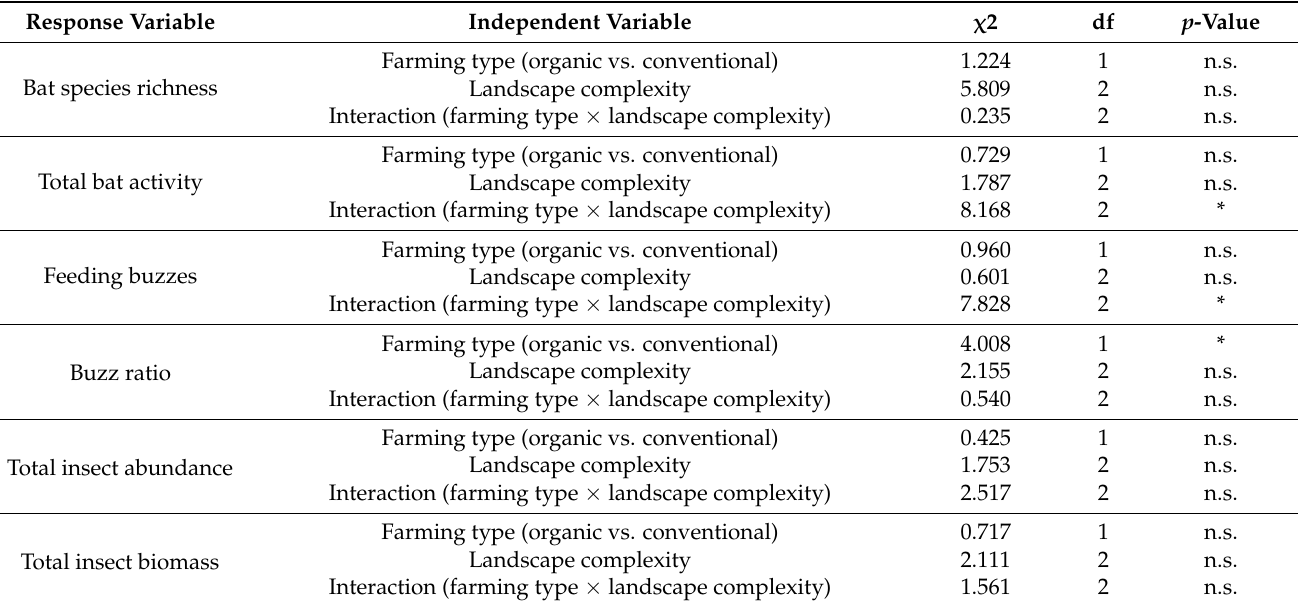
Table 3. Results of statistical analyses showing the effects of farming type, landscape complexity, and the interaction between farming type and landscape complexity on bat species richness, bat total activity, total number of feeding buzzes, buzz ratio, insect abundance, and insect biomass.